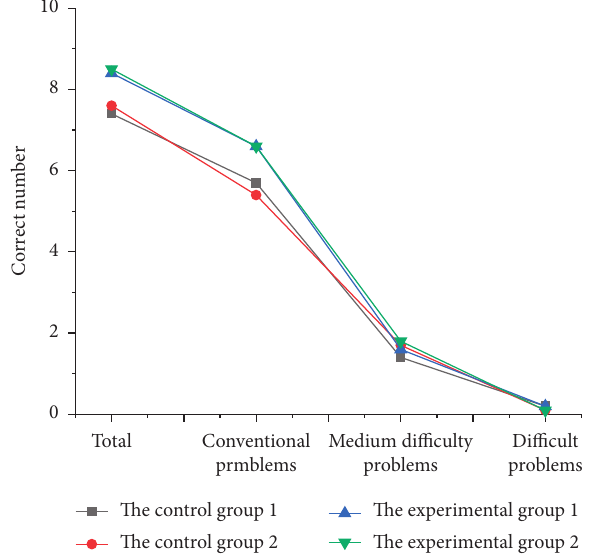
Figure 13: Comparison of the scores between the ordinary classroom and the classroom with digital twins